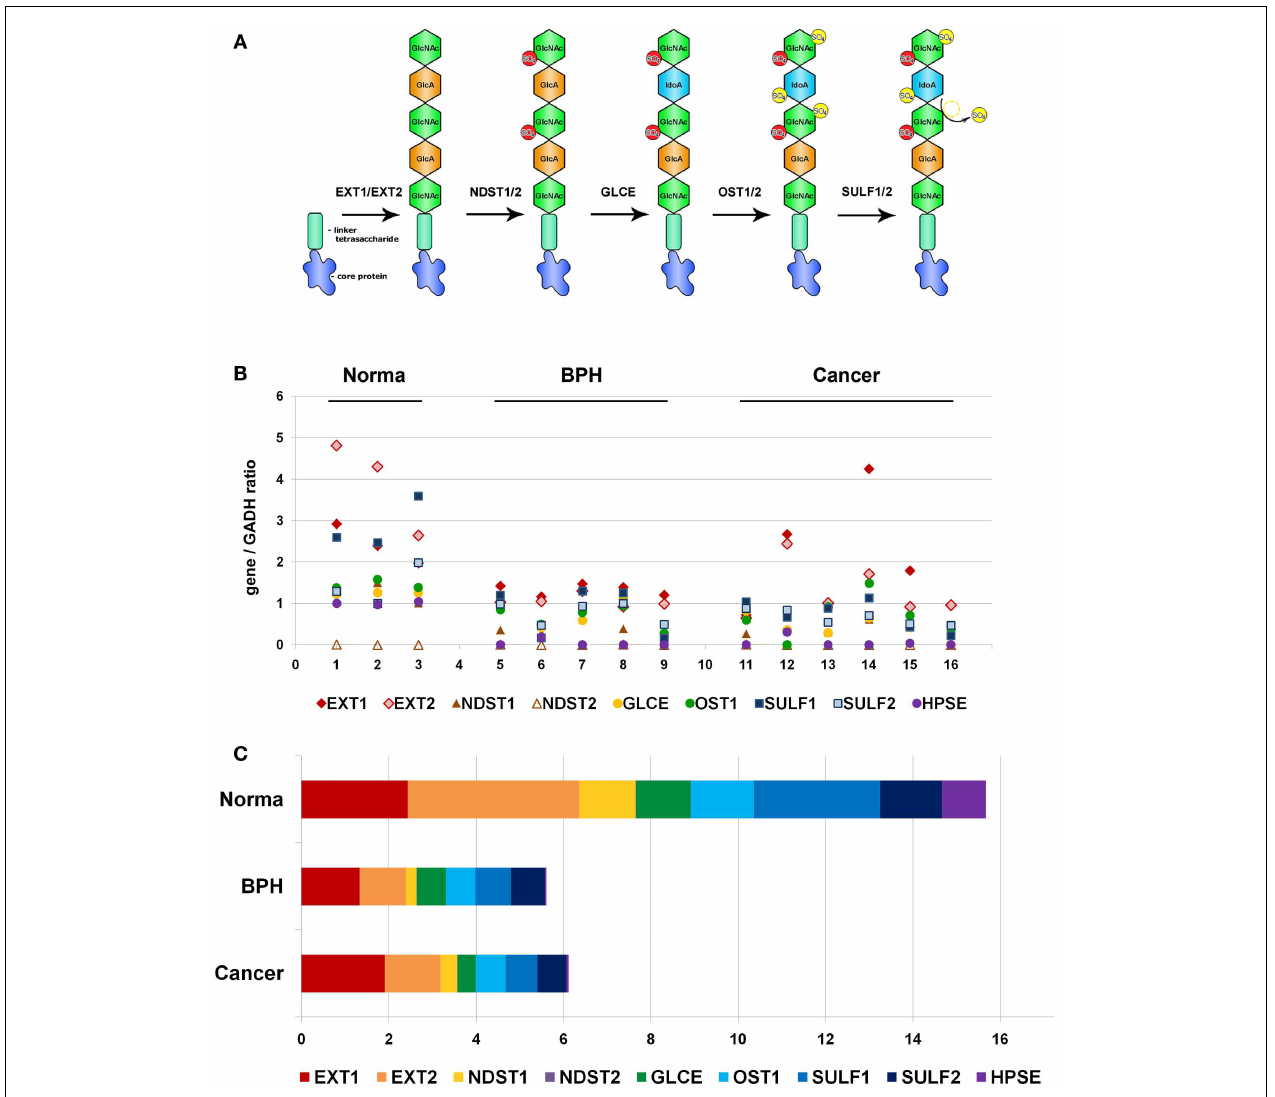
involved in HS biosynthesis, 1–16-patients. (C) Relative activity of HS-metabolic machinery in normal prostate tissue, BPH, and prostate